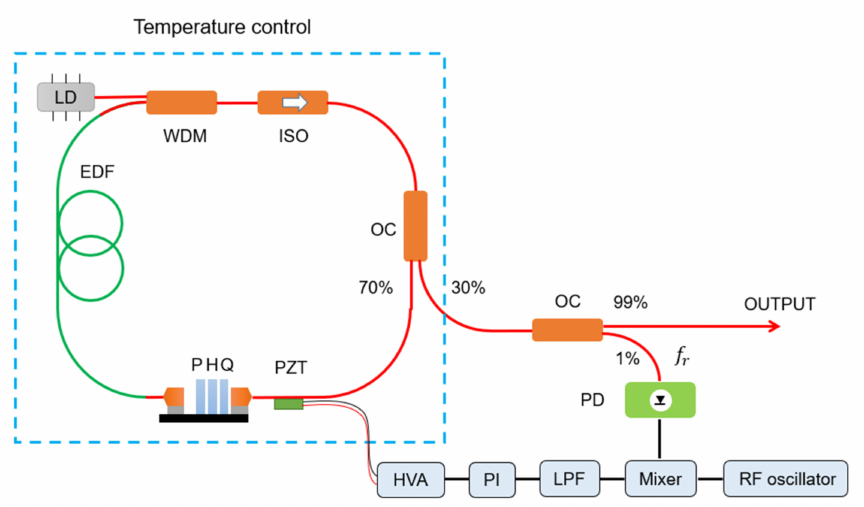
Figure 1. Fiber optical frequency comb (OFC) design. Red lines represent single-mode fiber paths, while black lines are electrical wires. LD: laser diode; EDF: erbium-doped fiber; WDM: wavelength division multiplexer; ISO: isolator; OC: optical coupler; Q: quarter-wave plate; H: half-wavelength plate; P: polarizer; PD: photodetector; LPF: low-pass filter; PI: proportional–integral controller; and HVA: high voltage